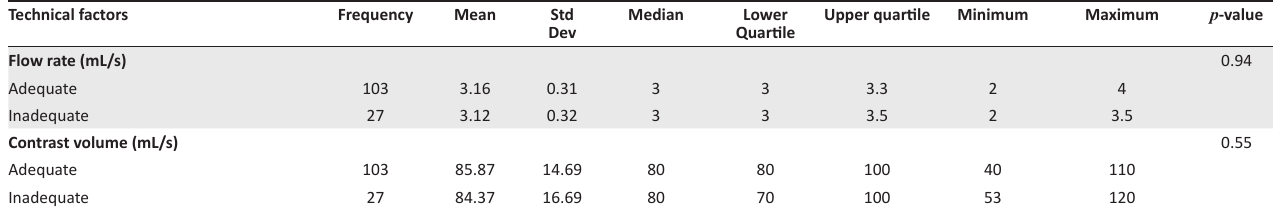
TABLE 2: Technical factors: Flow rate and contrast volume. Technical